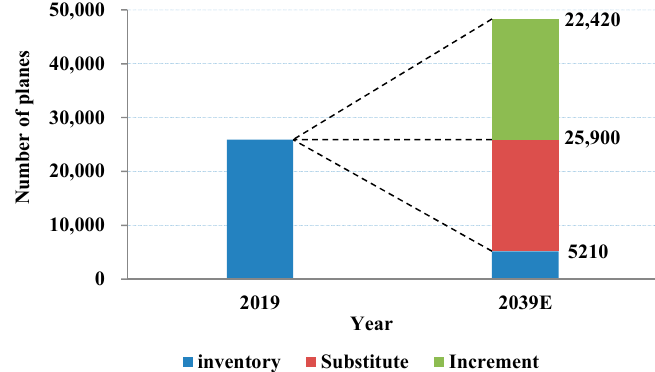
Figure 1. Boeing forecasts global aircraft demand [6].